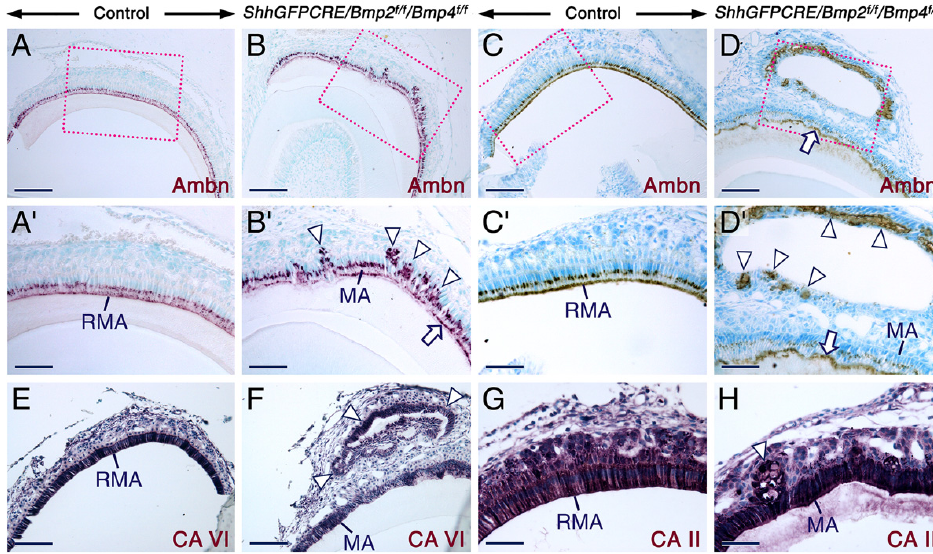
Figure 2. Enamel defects and abnormal development of maturation-stage ameloblasts upon com- bined loss of BMP2 and BMP4 signaling. ( A – H ) Sections across incisors at the level of early maturation-stage ( A , B ) and maturation stage ( C – H ) of amelogenesis from adult control ( A , C , E , G ) and ShhGFPCRE/Bmp2 f/f /Bmp4 f/f ( B , D , F , H ) mice. ( A – D ) Representative immunostaining (purple or brown) for ameloblastin (Ambn). ( A’ – D’ ) are magnified views of the boxed areas in ( A – D ). In the mutant teeth ameloblastin is detectable at the surface of the retained enamel matrix (arrows in ( B’ , D ) and ( D’ )) and is expressed by maturation-stage ameloblasts, including those that formed nodules and cyst-like structures outside of the ameloblast layer (arrowheads in ( B’ ) and ( D’ )). ( E – H ) Representative immunostaining (purple) for carbonic anhydrase VI (CAVI; ( E , F )) and carbonic anhydrase II (CAII; ( G , H )). In the mutant teeth maturation-stage ameloblasts, including those that formed nodules (arrowheads in ( F , H )), express CAVI and CAII. MA, maturation-stage ameloblasts; RMA, ruffle-ended maturation stage ameloblasts. Scale bars: 100 µ m ( A – D , E , F ) and 50 µ m ( G , H ). 2.2. Combined Loss of BMP2 and BMP4 Signaling in the Dental Epithelium Causes Development of Dysfunctional Maturation-Stage Ameloblasts Lacking a Ruffled Border and Exhibiting Altered Cell-Cell and Cell-Matrix Contacts Normal enamel maturation requires removal of EMPs from the developing enamel, and maturation-stage ameloblasts have been implicated in the reabsorption of degraded EMPs at the maturation stage of amelogenesis [52,53]. In maturation-stage ameloblasts, amelogenin immunoreactivity has been shown to be strong in multivesicular bodies and in the ruffled apical pole, while it is weak in cellular organelles involved in the secretory